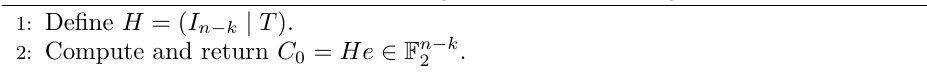
Algorithm 5 Encode ( e, T ) algorithm [ABC + 20, Sect.